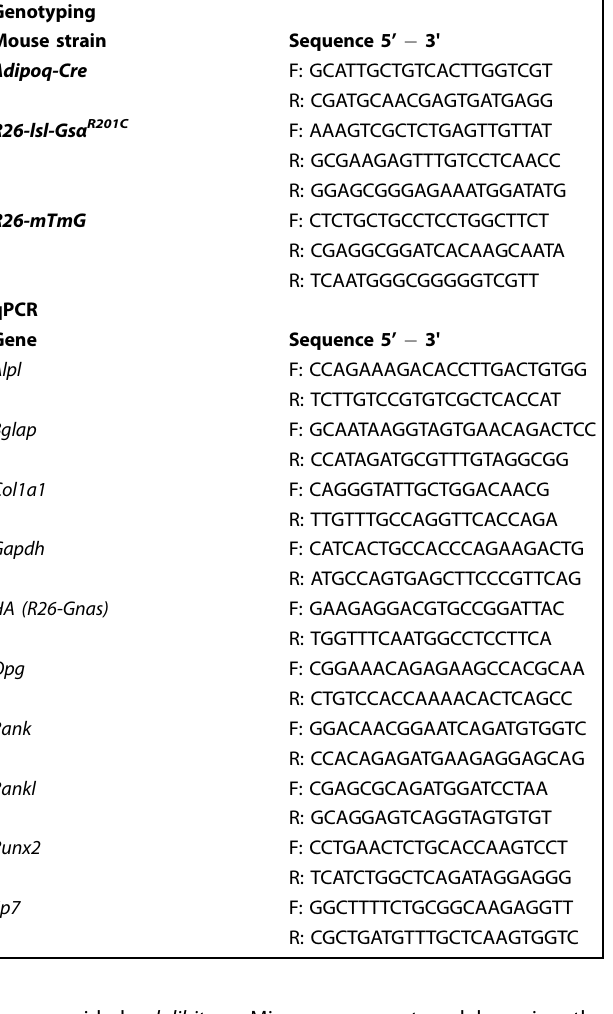
Table 1. Sequence of primers used for genotyping and qPCR